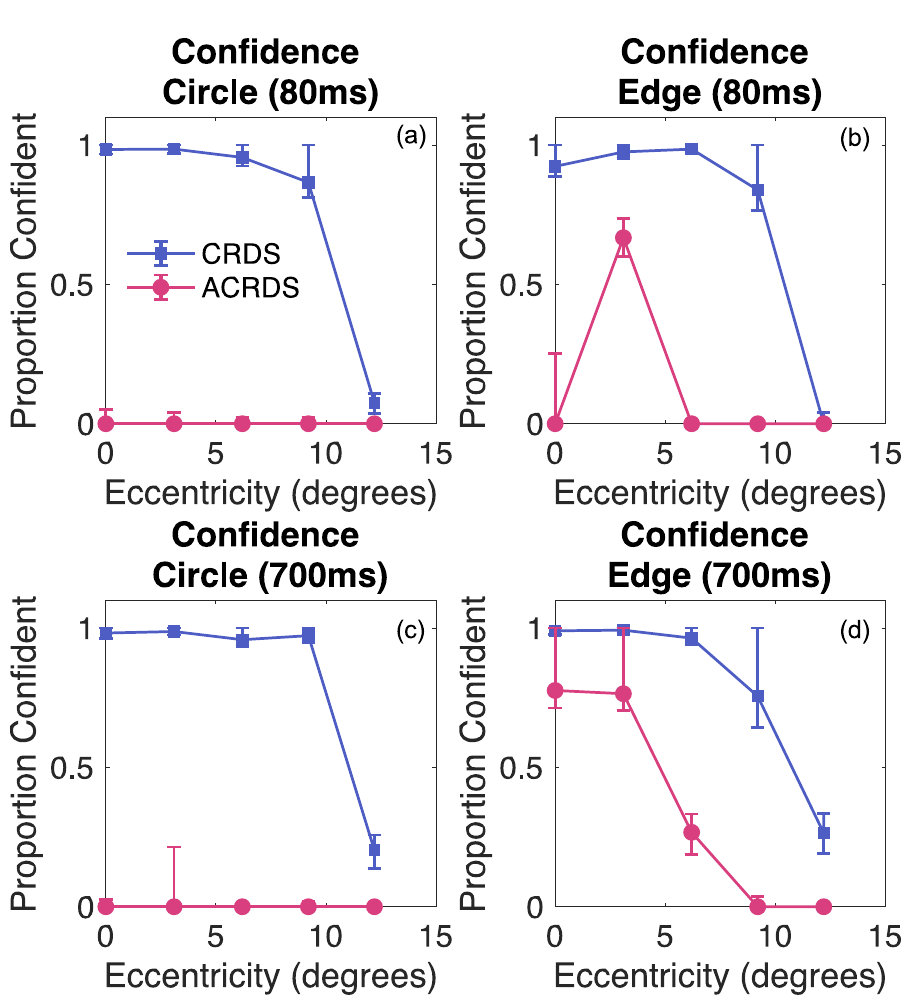
Fig 6. Proportion of confident responses as a function of eccentricity. The top row plots data for the short duration (80ms) for (a) circular and (b) horizontal edge stimuli. The bottom row plots data for the long duration (800ms) for (c) circular and (d) horizontal edge data. In all cases, the blue squares plot data for CRDS and the pink circles plot data for the ACRDS. Data show the mean results across participants, and bootstrapped 95 percent confidence limits. In all cases, confidence was high for centrally presented CRDS, and reduced with eccentricity. Confidence was generally low for ACRDS, with the exception of centrally presented edge stimuli at the long duration. judgments decreasing with eccentricity ( β =-0.014, t(13)=-5.31, p < 0.001) (Fig 5b). For anticor- related edge stimuli, depth was perceived in the natural direction ( β =0.916, t(13)=4.68, p < 0.001), with the reliability of these judgments decreasing with eccentricity ( β =-0.0020, t(13) =-2.94, p = 0.0116) (Fig 5b). Compared with the responses to anticorrelated circular stimuli, responses were reliable (overall 70% versus 47% correct responses). Circular stimuli at the long duration (700ms) . For correlated stimuli, depth was perceived in the natural direction ( β =4.61, t(13)=12.05, p < 0.001), with the reliability of these judgments decreasing with eccentricity ( β =-0.008, t(13)=-8.84, p < 0.001) (Fig 5c). For anticorrelated sti- muli, there was a tendency for depth to be perceived in the reverse direction ( β =-0.391, t(13)=- 3.68, p = 0.0028) (Fig 5c). This did not vary with eccentricity ( β =0.0004, t(13)=1.10, p = 0.290). Horizontal edge stimuli at the long duration (700ms) . For both correlated ( β =3.35, t(13) =9.29, p < 0.001) and anticorrelated ( β =1.29, t(13)=8.26, p < 0.001) stimuli, depth was perceived